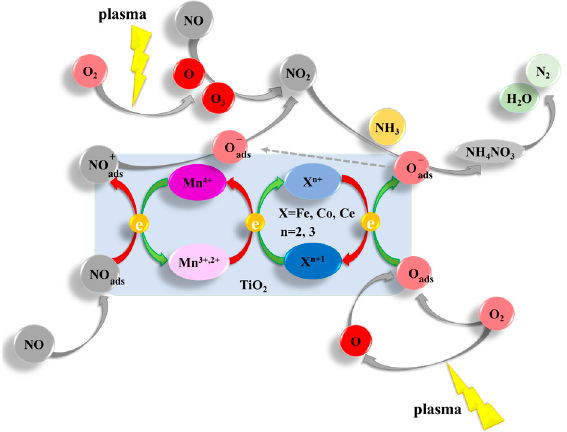
Figure 9. The possible catalyst-plasma hybrid catalytic process of SCR reaction over Mn-based 550 bimetallic nanocatalysts. 551